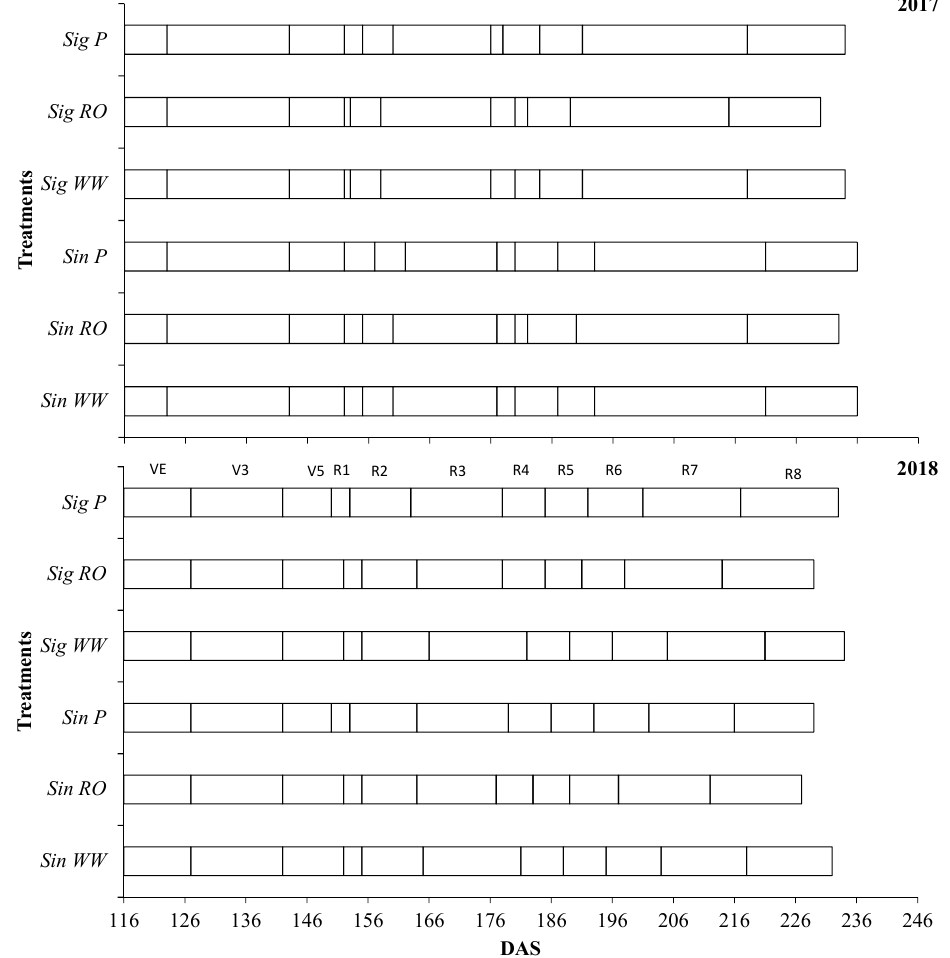
Figure 2. Length of soybean phenological phases in 2017 and 2018 based on days after sowing ( DAS ) according to Fehr and Caviness (1977) [27]. Top figure = 2017; bottom figure = 2018. Abbreviations: VE—emergence; V3—third node; V5—fifth node; R1—start of bloom; R2—full bloom; R3—start of